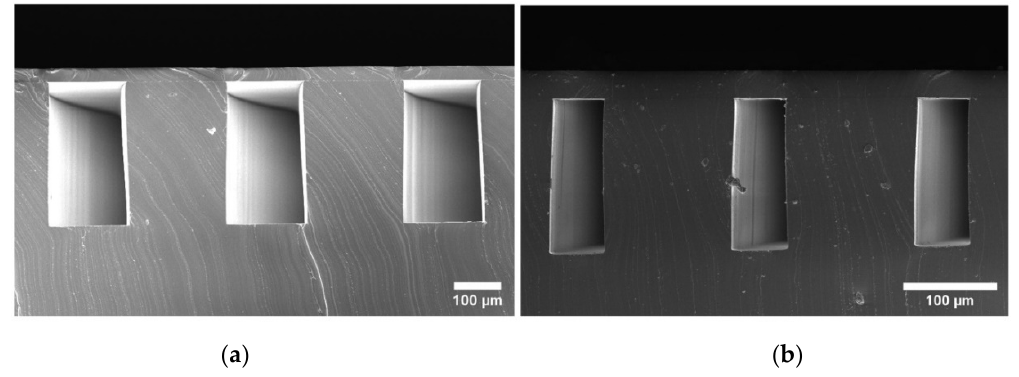
Figure 3. FESEM images of microdevice A (Panel ( a )) and B (Panel ( b )). Microdevices were cut to expose microdevice channels. White bars represent 100 µm.